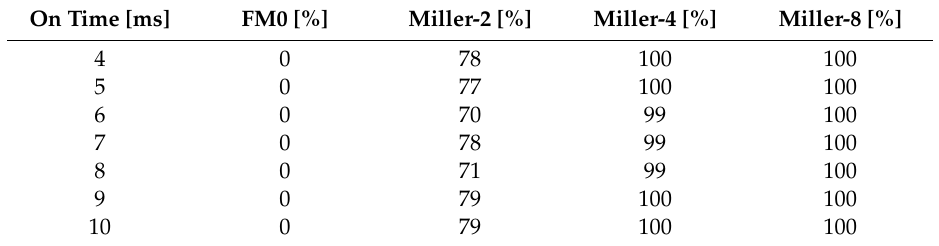
Table 3. Percentage of recorded readings for each encoding typology and activation time, using a Tari value of 25 µ s.